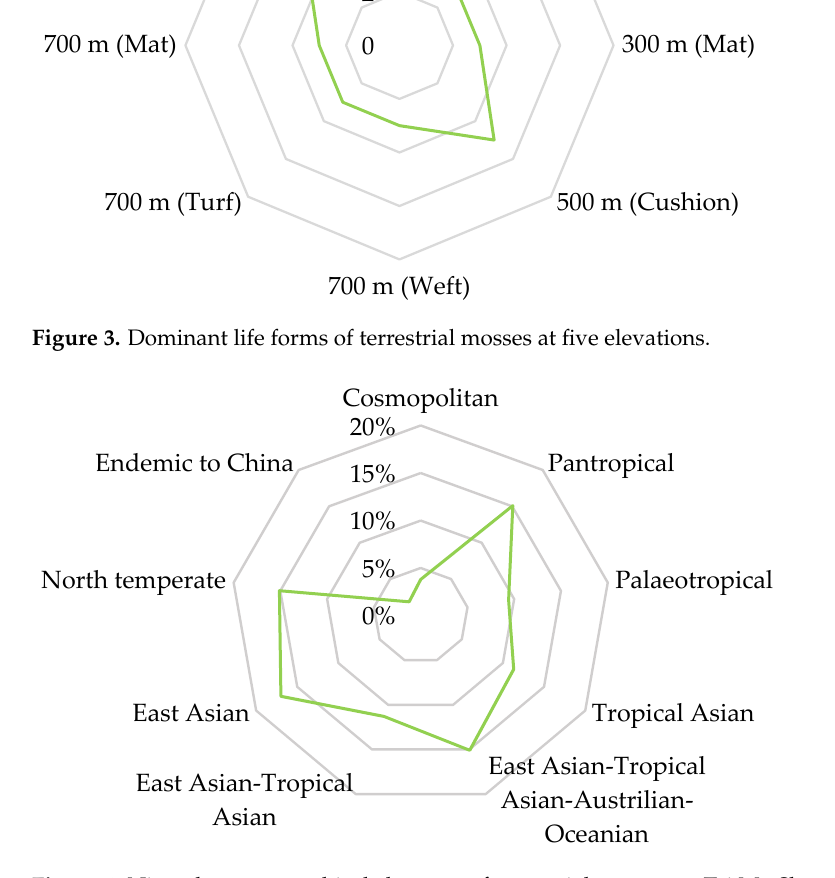
Figure 4. Nine phytogeographical elements of terrestrial mosses on Tai Mo Shan. Table 3. General phytogeographical elements of terrestrial moss species on Tai Mo Shan.